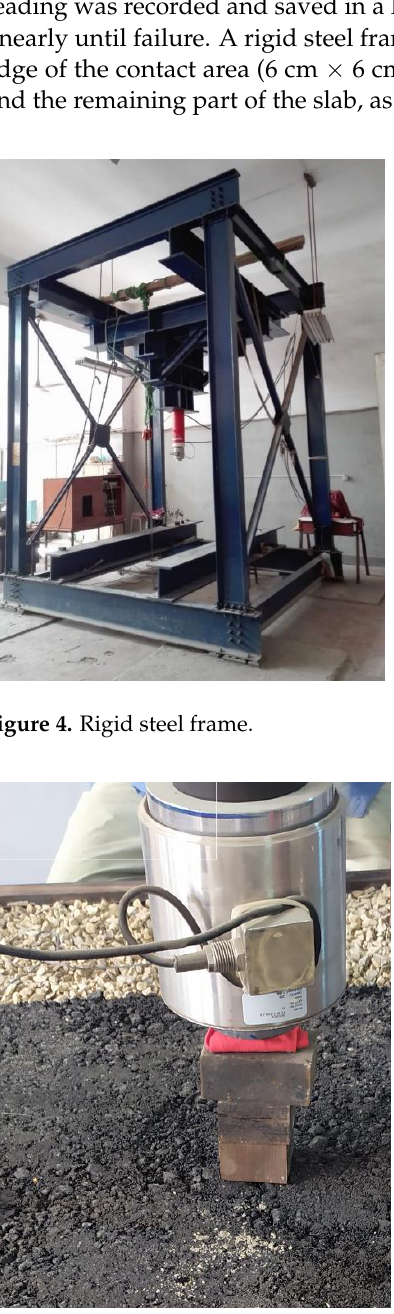
Figure 5. Location of a concentrated load of rigid steel frame.